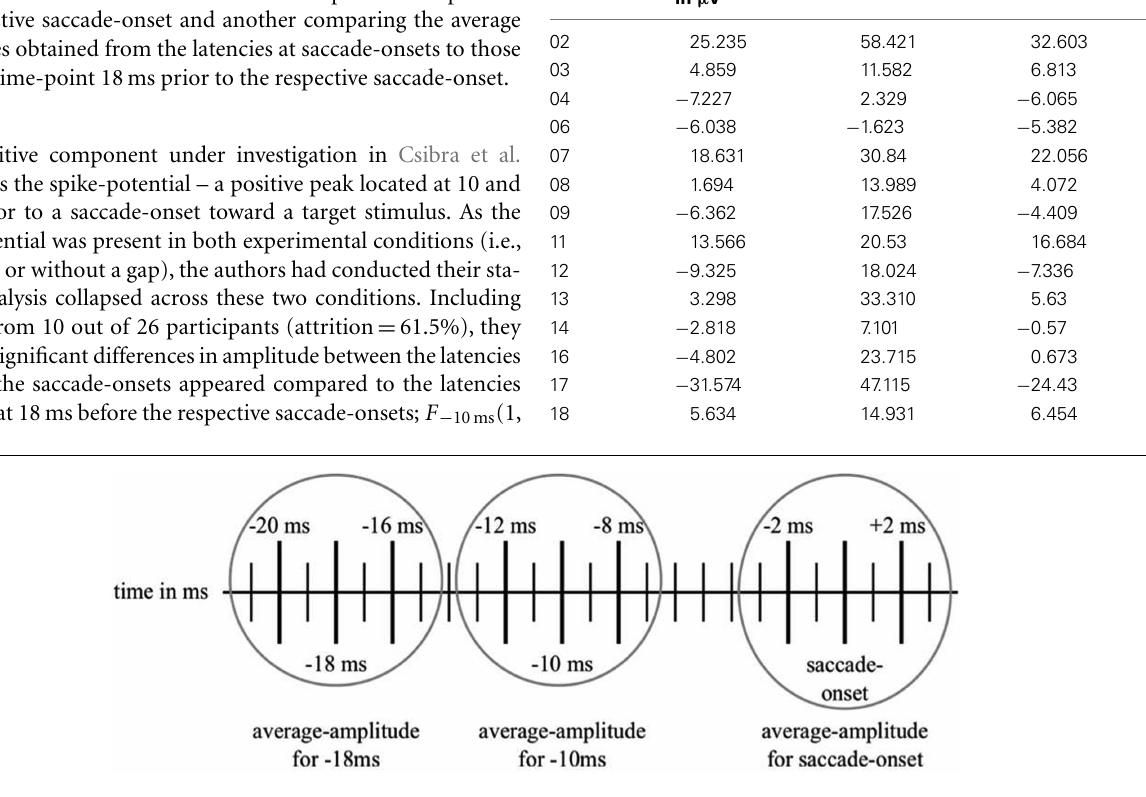
FIGURE 2 |An illustration of our sampling method used for collecting the data for the amplitude-comparison between saccade-onset and the time-points of − 10 and − 18ms before saccade-onset. The highlighted